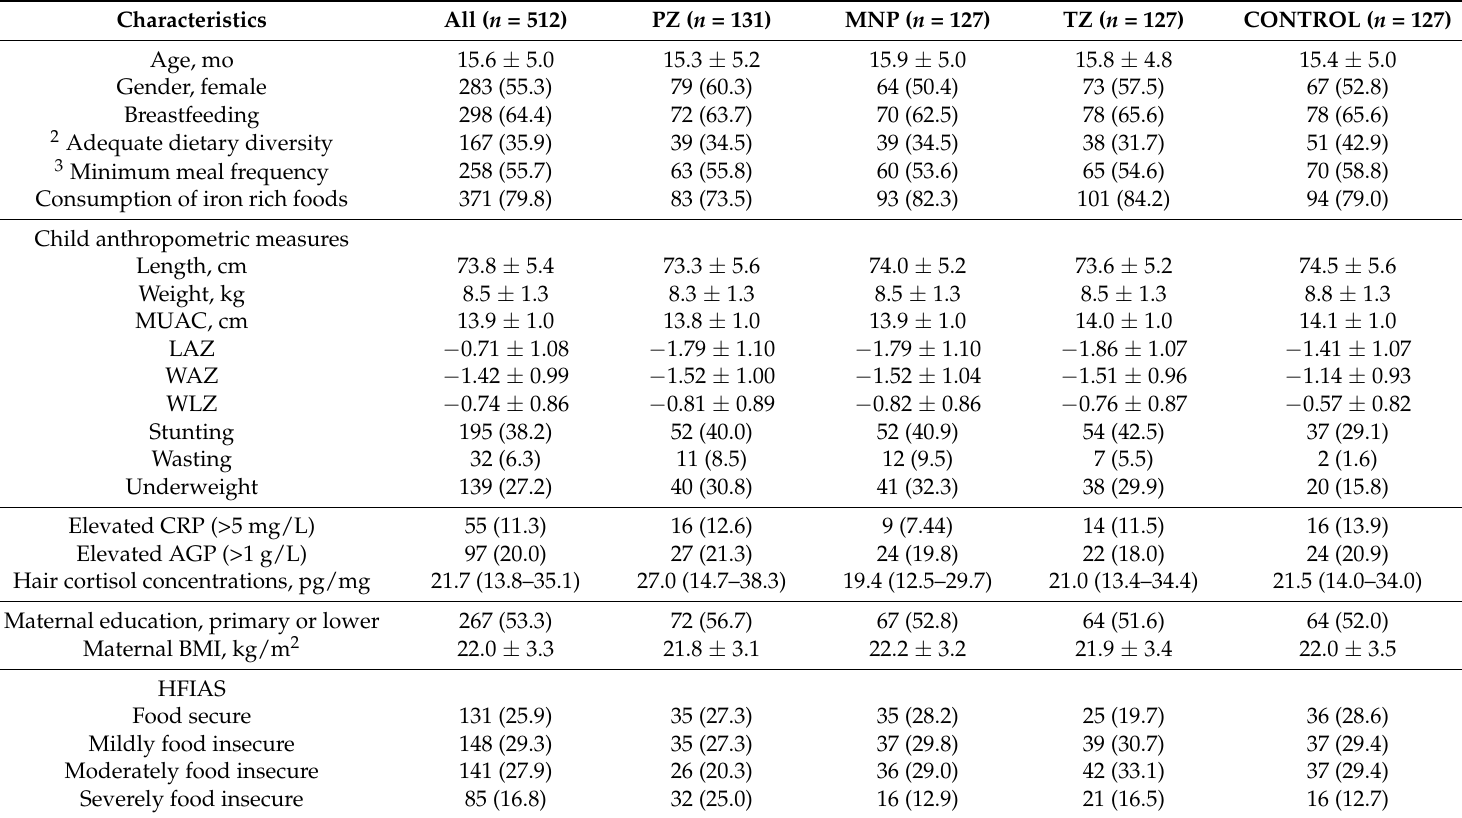
Table 1. Child, maternal and household characteristics of the study participants at baseline by intervention group 1